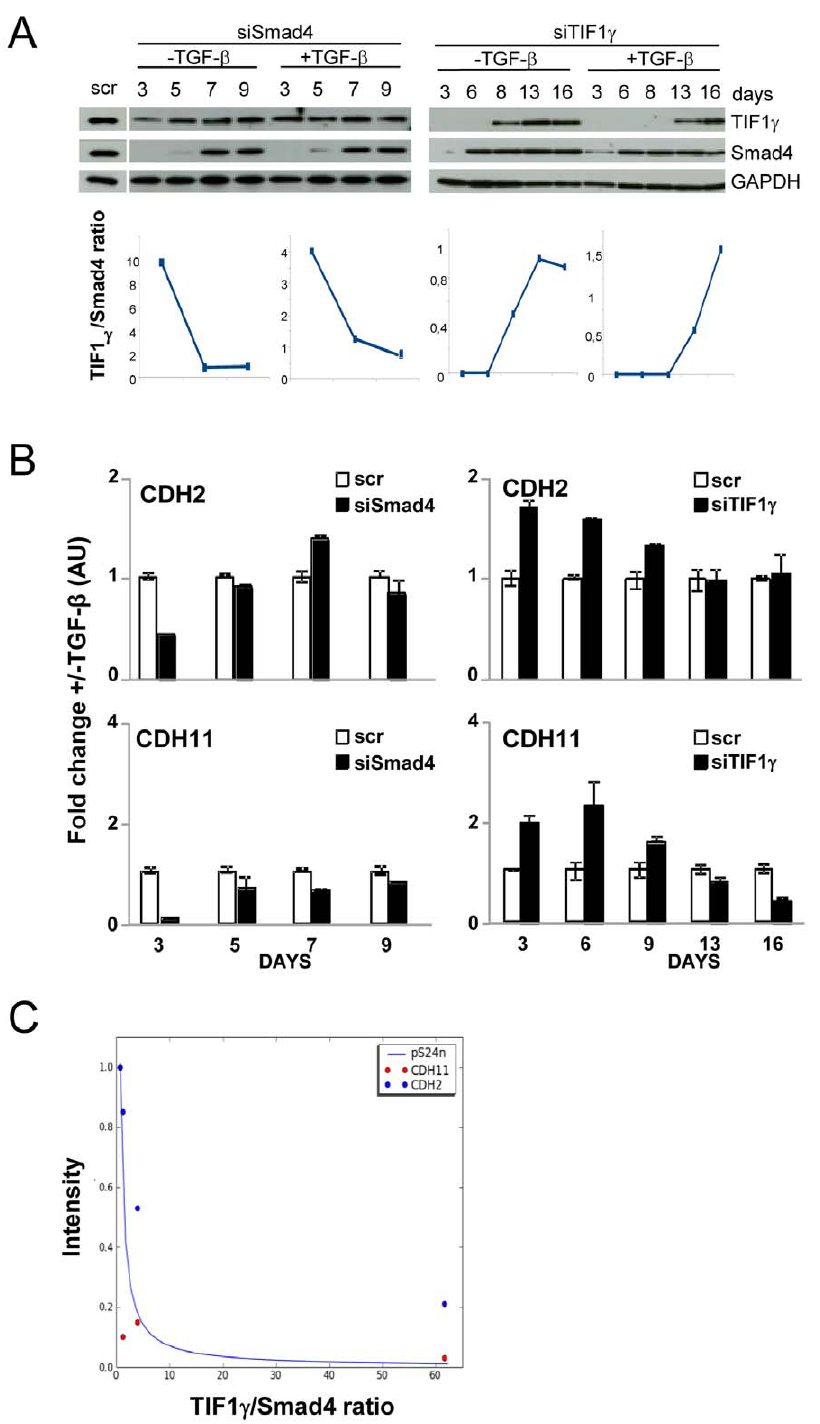
Figure 5. Expression of the CDH2 and CDH11 TGF- b target genes is sensitive to TIF1 c /Smad4 ratios. HMEC cells were transfected with Smad4 (siSmad4) or TIF1 c (siTIF1 c ) siRNAs and cultured in the presence ( + ) or absence ( 2 ) of TGF- b for the indicated times (days). Controls were cells transfected with non-targeted siRNA (scr). A) Smad4 and TIF1 c protein levels were analyzed by immunoblotting (upper panels) and quantified by densitometric scanning (lower panels). B) TGF- b -induced fold changes in CDH2 and CDH11 expression were analyzed by RT–qPCR. All values were normalized to the amount of HPRT mRNA and expressed relative to the value obtained for TGF- b -untreated controls in arbitrary units (AU). Results are expressed as the mean 6 SD of 3 independent experiments. C) mRNA levels of CDH2 (red circles) and CDH11(blue circles) were plotted against TIF1 c / Smad4 ratios and were fitted to the predictive equation curve of pS24n relative concentrations.